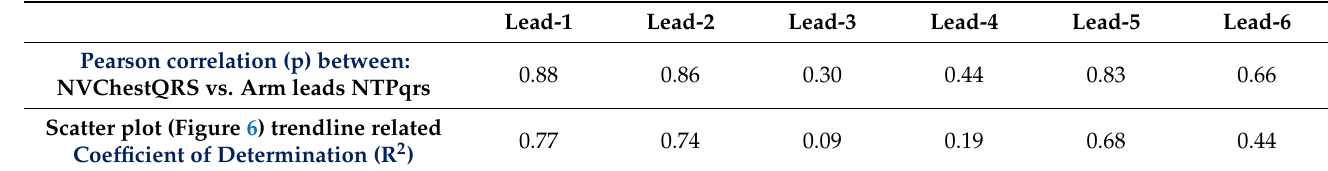
Figure 7. Scatter plot of 18 data pair/case points and associated trendline coefficient of determination (R 2 ) of NTPqrs metric on arm leads (1–6) versus values of NVChestQRS on the Chest Lead-I. Table 5. Results summary of Pearson Correlation coefficient (p) and scatter plot (Figure 7) associated trendline coefficient of determination (R 2 ) between number of valid QRS events in the Chest Lead I (NVChestQRS) and the number of true positive QRS (NTPqrs) events on the six bipolar arm leads. Lead-1 Lead-2 Lead-3 Lead-4 Lead-5 Lead-6 Pearson correlation (p) between: 0.88 0.86 0.30 0.44 0.83 0.66 NVChestQRS vs. Arm leads NTPqrs Scatter plot (Figure 6) trendline related 0.77 0.74 0.09 0.19 0.68 Coefficient of Determination (R 2 )